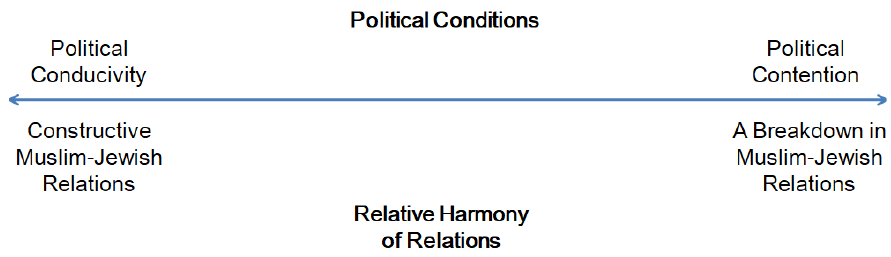
Figure 1. Proposed Spectrum for the Political Conditionality of Muslim-Jewish Harmony.